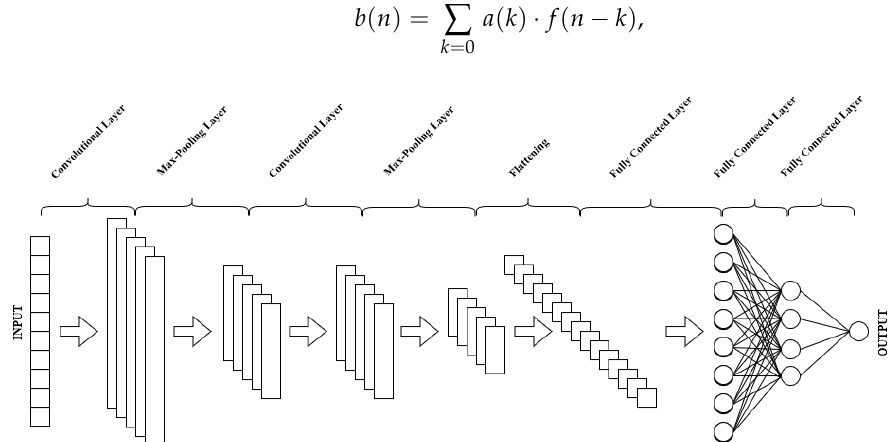
Figure 2. General structure of the proposed